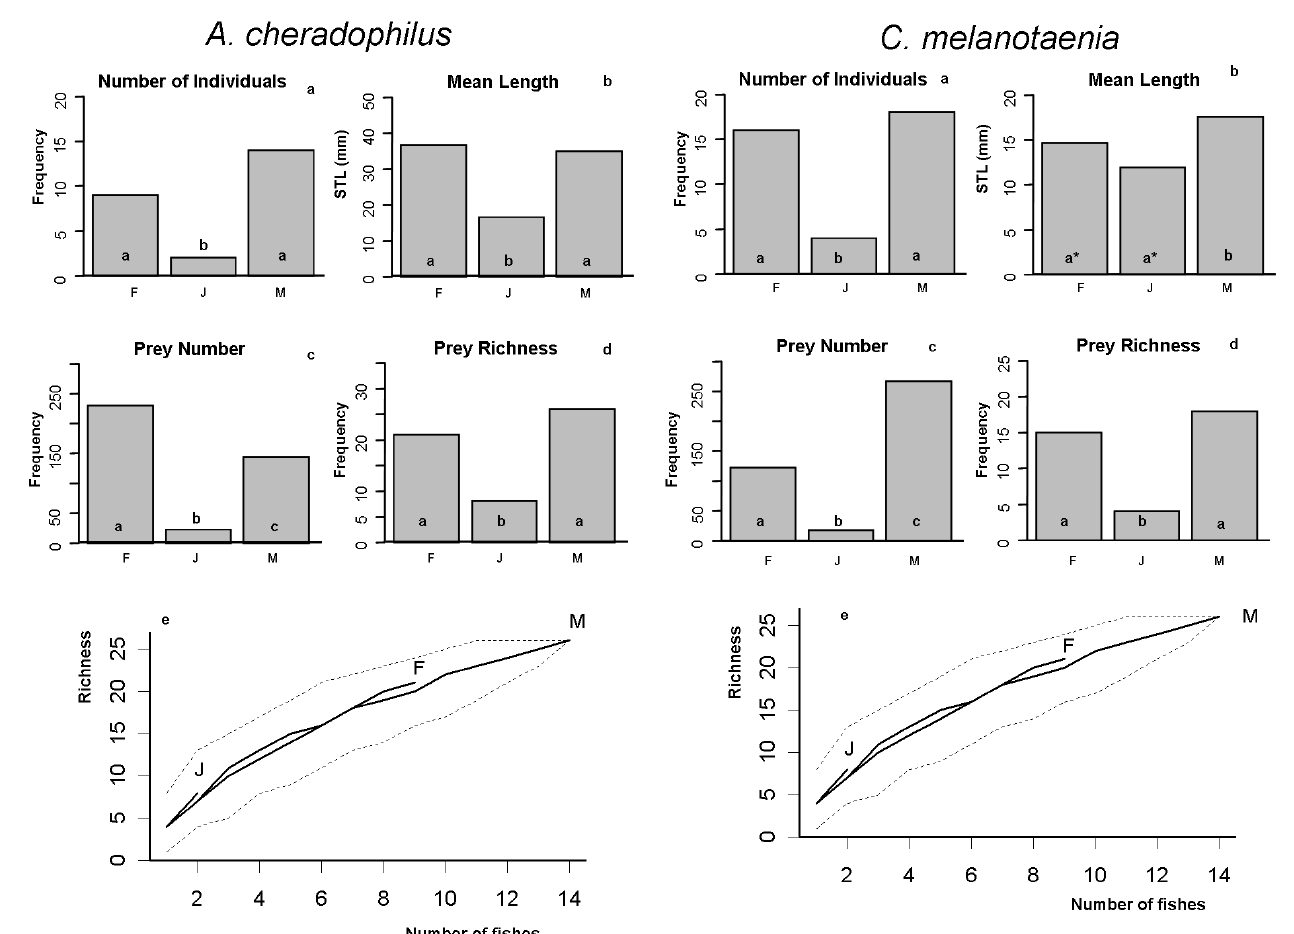
Fig. 5. Sampled fishes of C. melanotaenia and differences between demographic groups (F, J and M) in: (a) number of collected individuals, (b) body sizes measured as STL, (c) total number of prey recorded at gut analysis, and (d) prey richness at the taxonomic level detailed in Table 1. (e) Rarefaction curves for each class. Dashed lines indicate the confident interval at